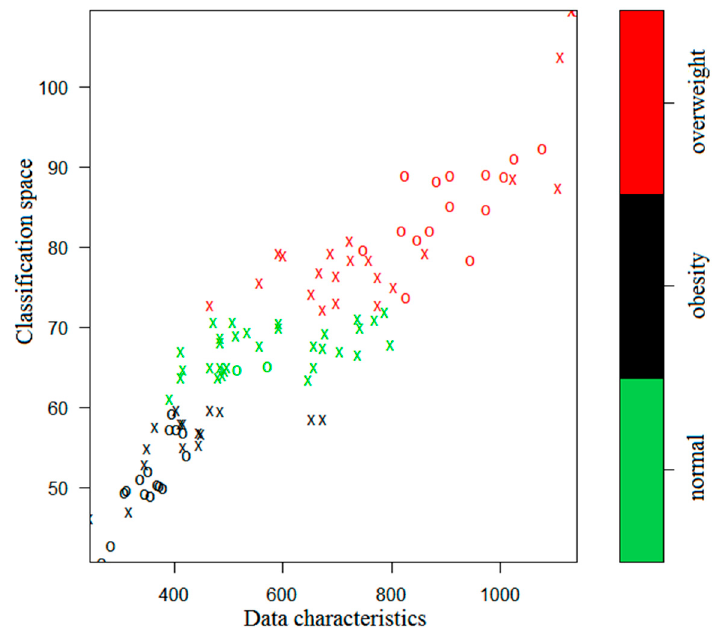
Figure 3. Classification for the 1 KHz case by the iSVM.